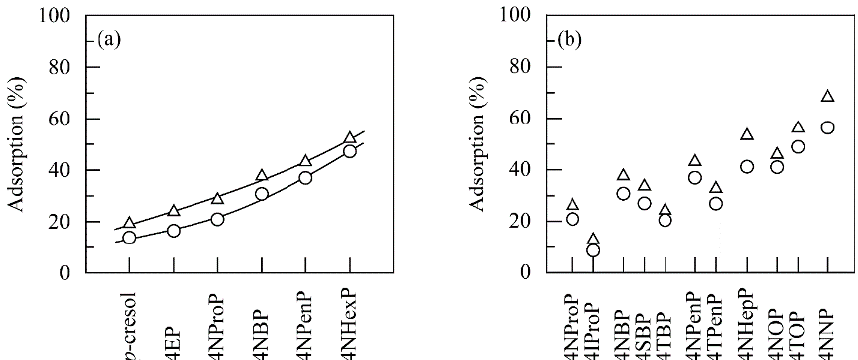
Figure 6. Removal of linear (( a ) and ( b )) and branched ( b ) alkylphenols on chitosan beads in the absence of PPO for stirring times of 6 ( ○ ) and 24 ( △ ) h at pH 7.0 and 40 °C. 3.3. PPO-Catalyzed Quinone Oxidation and Subsequent Quinone Adsorption on Chitosan Powder